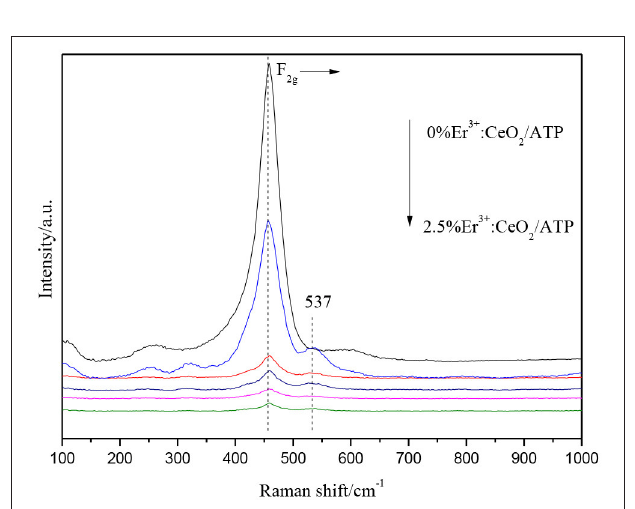
FIGURE 3 | Upconversion PL patterns of different Er doping fraction.